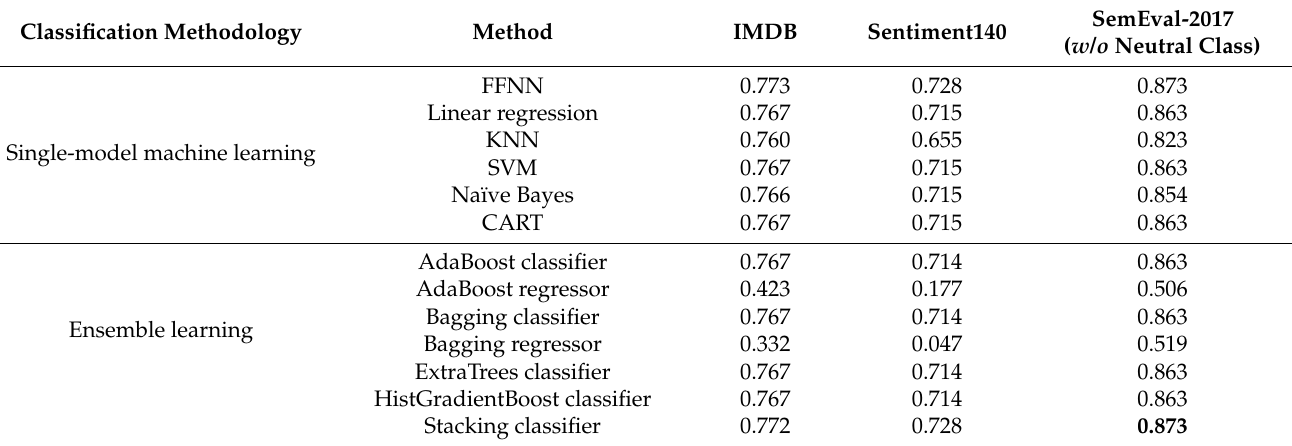
Table 7. Accuracy of classifiers on three benchmark (IMDB, Sentiment140 and SemEval-2017) datasets. The best result is shown in